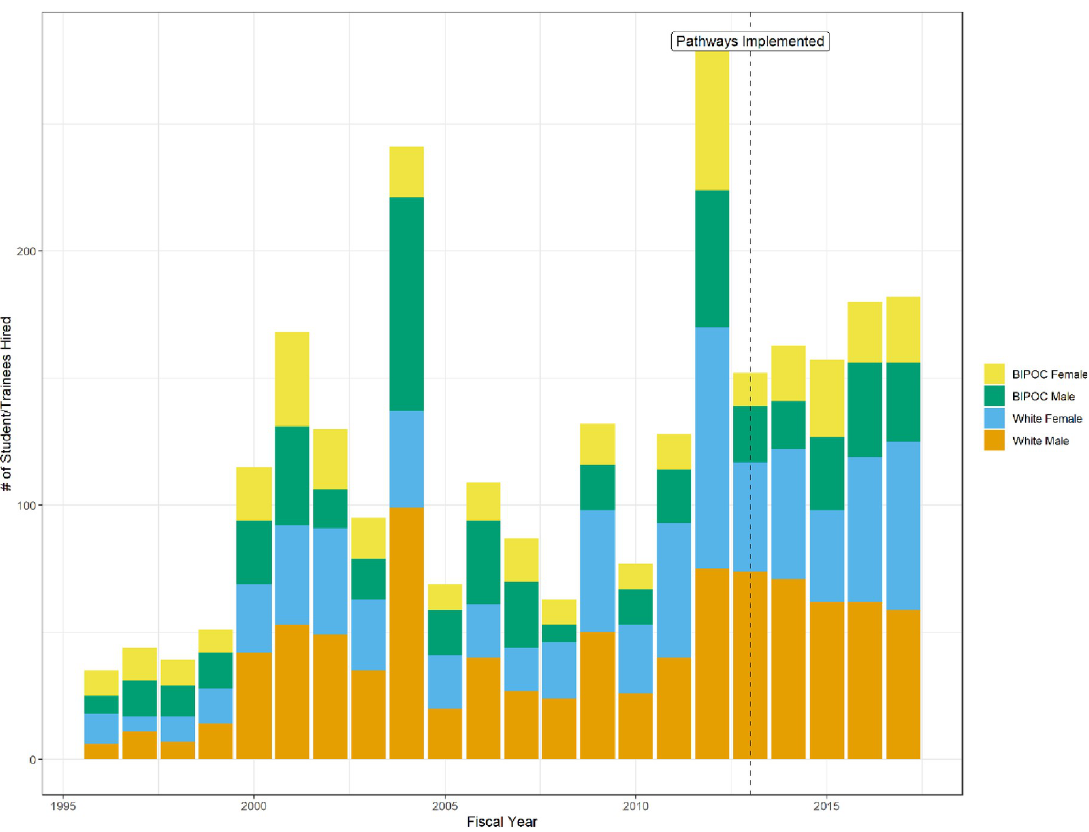
Fig 1. Number of student and recent graduate trainees entering USDA forest service between 1996 and 2017.